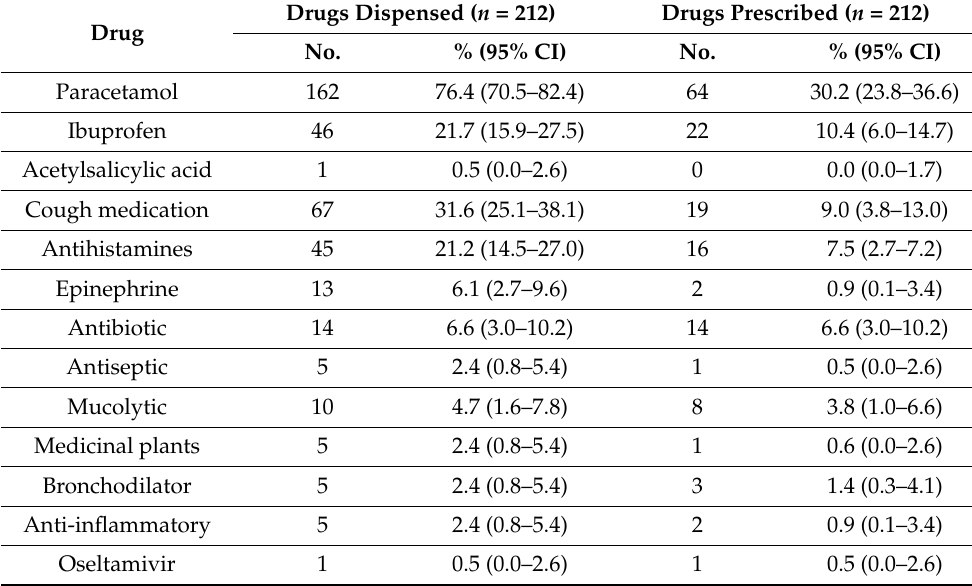
Table 4. Drugs dispensed by sentinel pharmacies and drugs prescribed by physicians to influenza-like illness patients with a negative COVID-19 test in Catalonia (Spain) in the 2021–2022 influenza